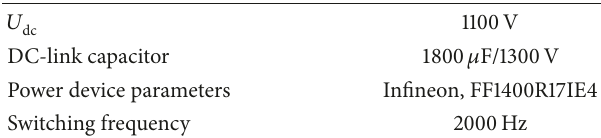
Table 4: Component parameters of inverter main circuit. 𝑈